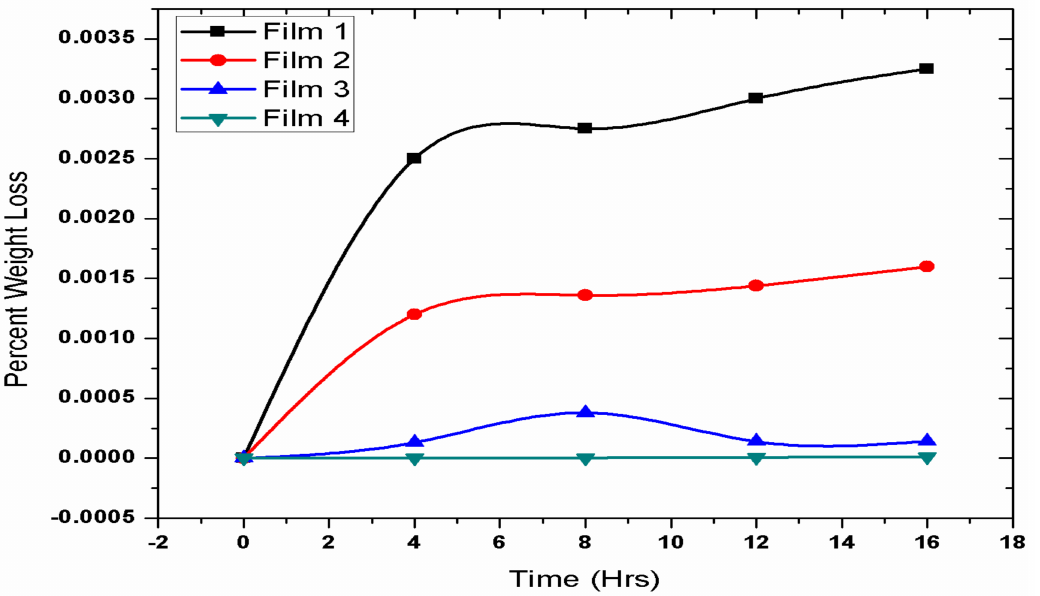
Figure 4. Biodegradation curves for F-1 (80% PLA and 20% EVA), F-2 (70% PLA and 30% EVA), F-3 (50% PLA and 50% EVA) and F-4 (30% PLA and 70%